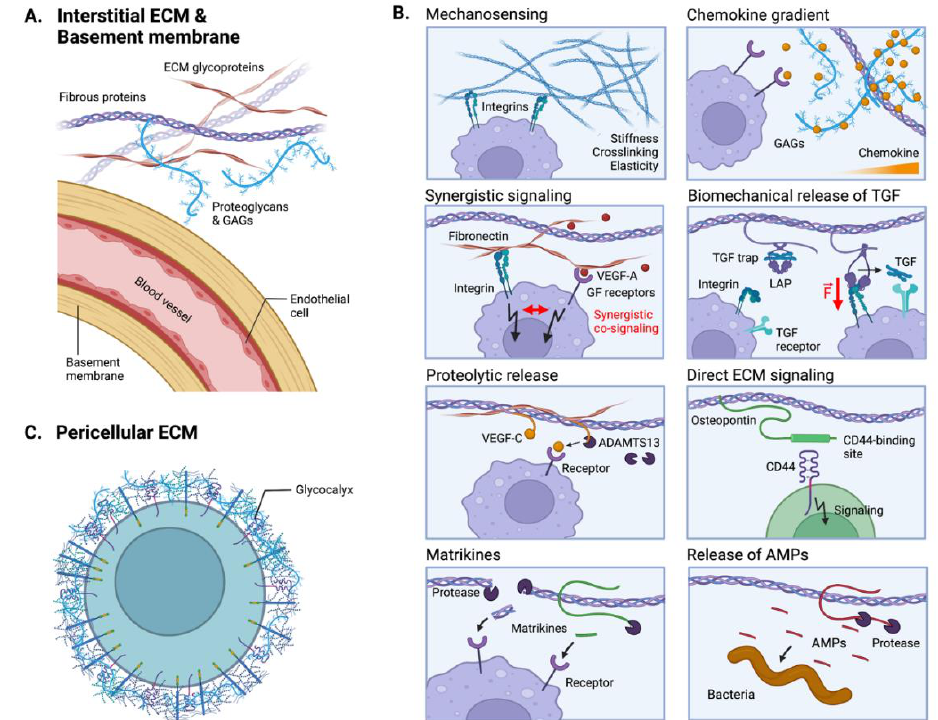
Figure 6. The immunomodulatory role of the ECM and examples of associated molecular mechanisms. ( A ) Schematic view of the interstitial ECM and the basement membrane localization in tissues and key components. ( B ) Example of immunomodulatory mechanisms involving interactions with the ECM. The ECM has key roles in transducing mechanical signals into cells, creating chemokine gradients and modulating bioavailability and signaling of bioactive proteins. The ECM additionally releases bioactive domains upon cleavage, directly signaling immune cells to modulate their behav- ior or acting as anti-microbial peptides (AMPs). ( C ) The pericellular ECM called the glycocalyx,